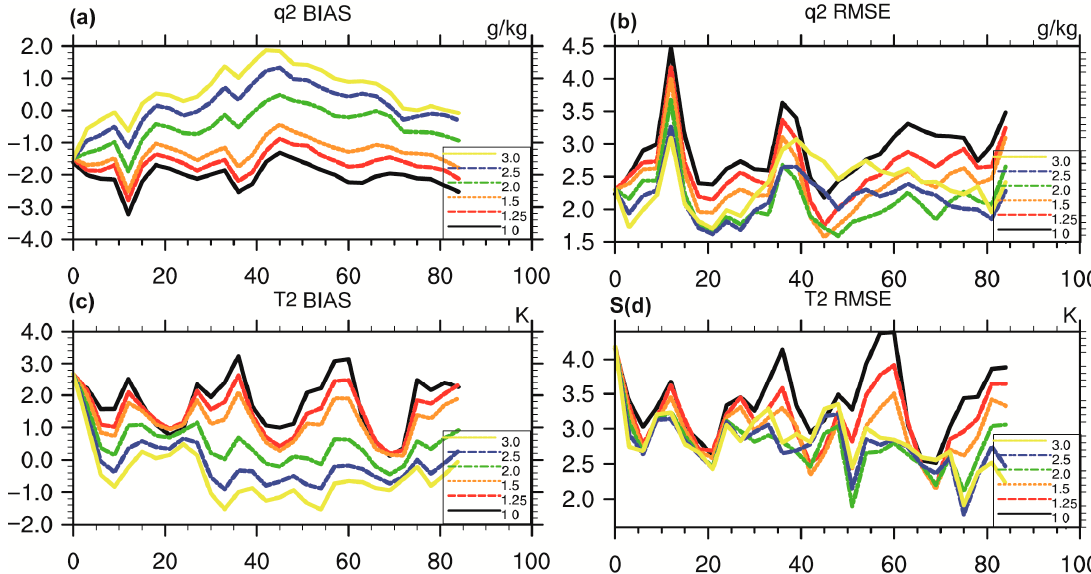
Figure 8. The ( a ) 2-m specific humidity BIAS; ( b ) 2-m specific humidity RMSE; ( c ) 2-m temperature BIAS and ( d ) 2-m temperature RMSE verified against observations of 105 meteorological stations in Xinjiang under different soil moisture initial conditions. Note that the 1.0, 1.25, 1.5, 2.0, 2.5 and 3.0 multiples of NCEP GFS soil moisture are denoted as black, red, orange, green, blue and yellow lines, respectively. The figure shows the verification results of the surface forecasts. The x -axis represents the hours since the simulation, while the y -axis represents the BIAS or RMSE.